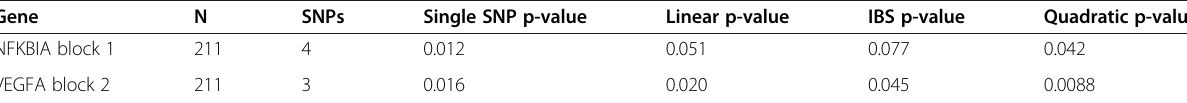
Table 4 Gene and haplotype ALI associations in European Ancestry trauma subjects Gene N SNPs Single SNP p-value